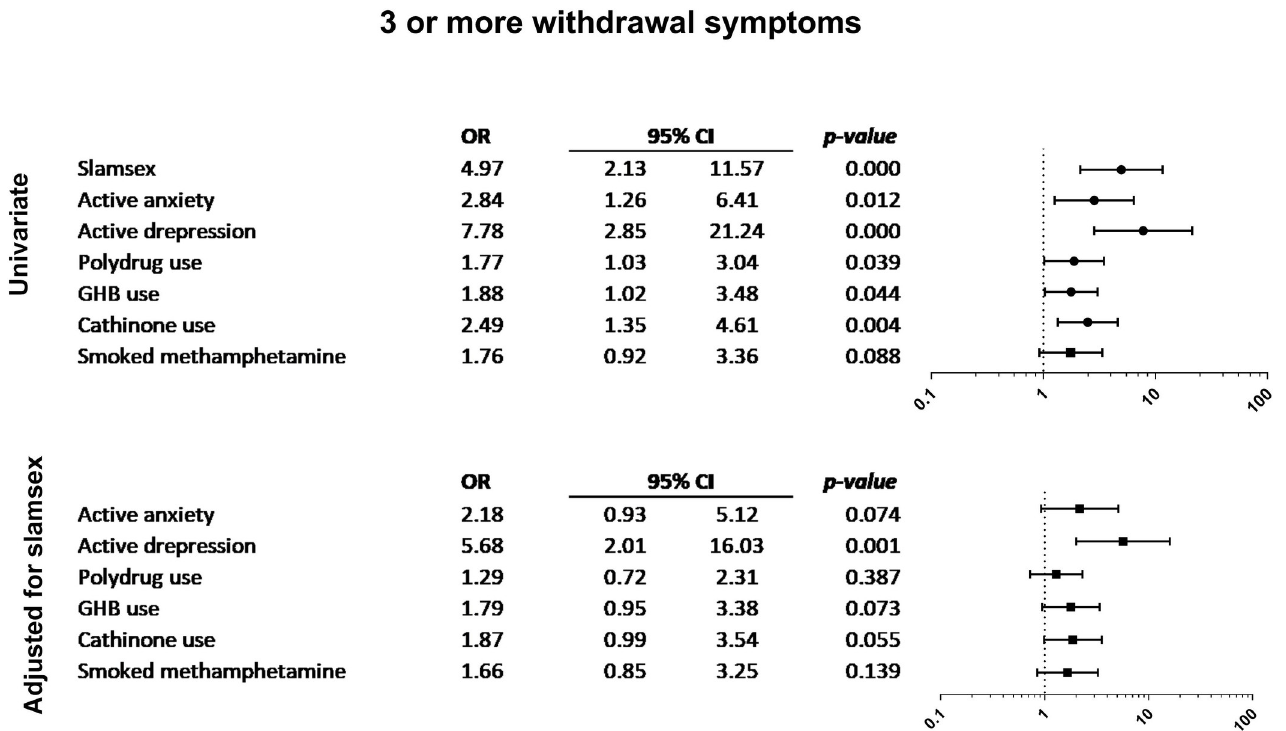
Fig 1. Association between current self-reported psychiatric diagnosis and 3 or more withdrawal symptoms.